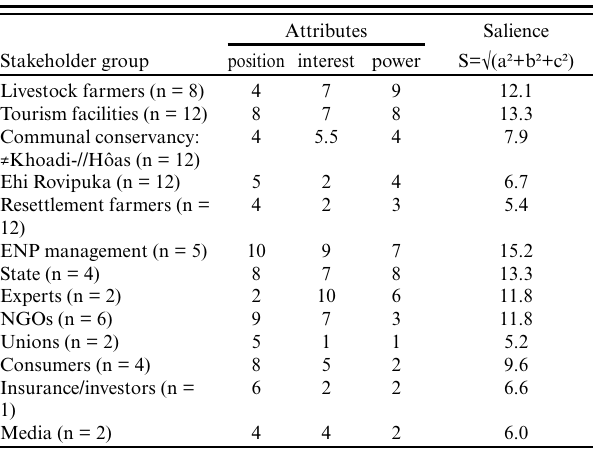
Table 4 . Median stakeholder attribute values and calculated salience values of respondents involved in the expansion of the protected area network around Etosha National Park.